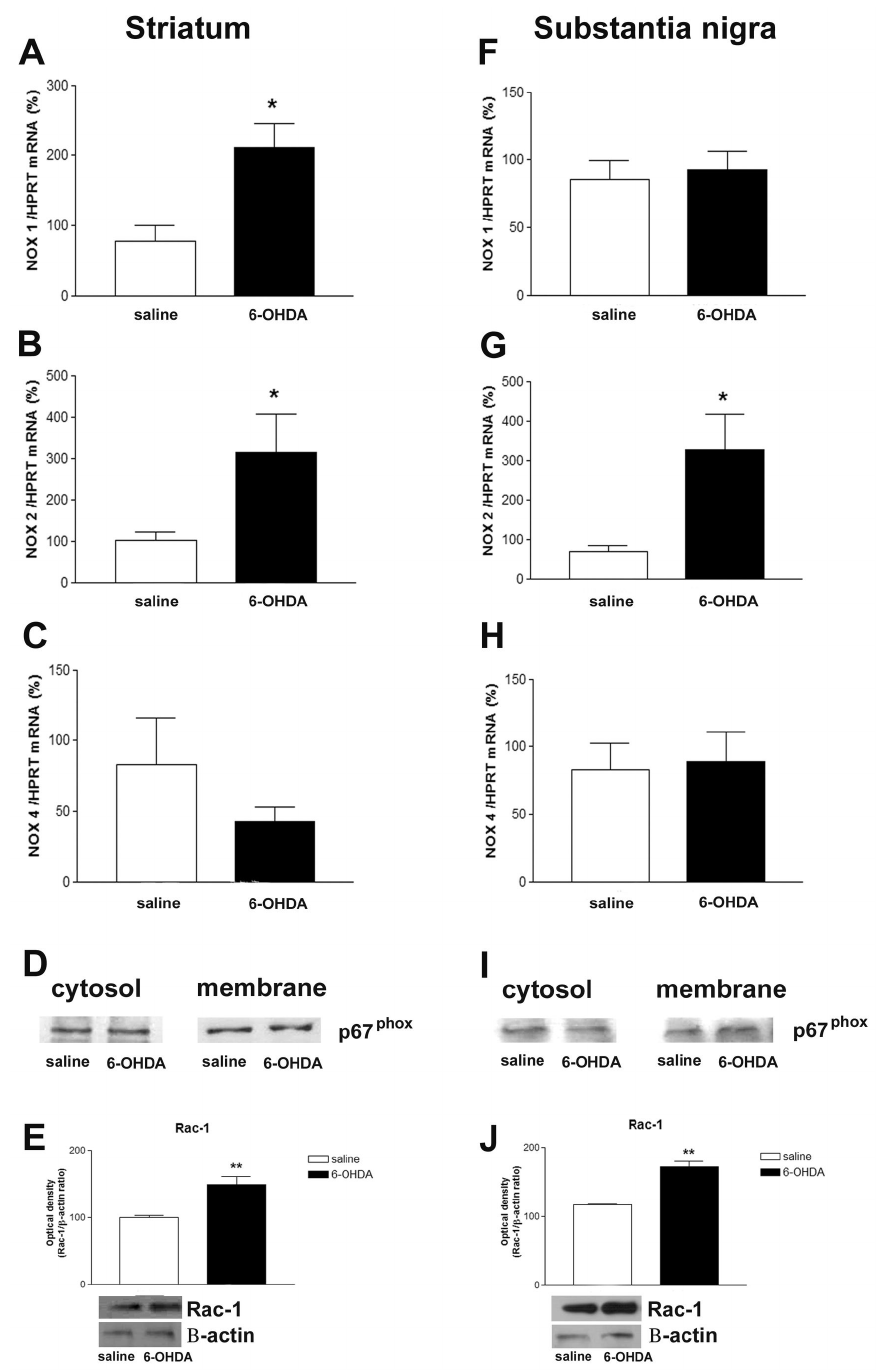
Figure 1. Six-OHDA leads to Nox activation. Effect of 6-OHDA on mRNAs of Nox1 (A), Nox2 (B) and Nox4 (C) isoforms in the striatum. HPRT was used as an internal control; n=6. The statistical significance is expressed as: * P < 0.05. In D and I, representative Western blots illustrating p67 phox protein content in cytosolic and membrane fractions obtained from striatum and SN respectively, after 6-OHDA-induced PD. Six-OHDA did not induce significant p67 phox translocation from the cytosol to the plasma membrane in none of the analyzed samples; n=4 tested samples. In E and J, effect of 6-OHDA on striatal and SN Rac-1 total protein levels. The graphs represent the mean ratio of Rac-1 densitometric data in relation to β-actin of 5 tested samples. Significance compared to Wt saline at **p <0.01. In F, effect of 6-OHDA on mRNAs of Nox1 (F), Nox2 (G) and Nox4 (H) isoforms in the SN. HPRT was used as an internal control; n=6. The statistical significance is expressed as: * P < 0.05. doi: 10.1371/journal.pone.0075532.g001 PLOS ONE |